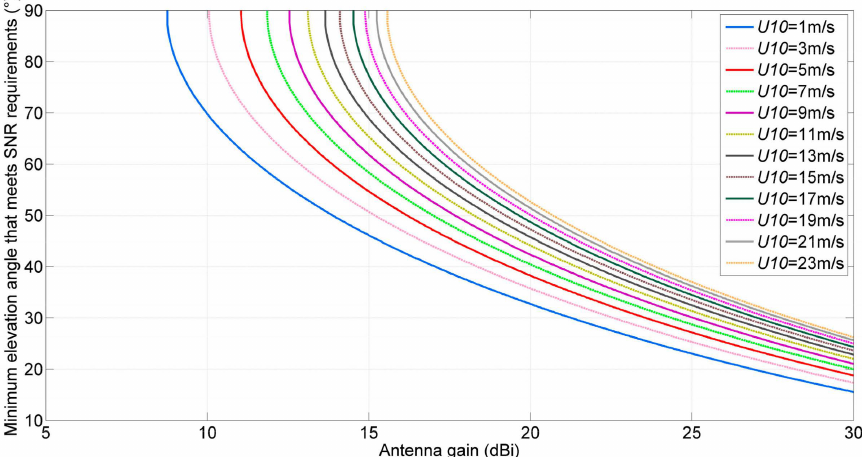
Figure 5. The relationship between the minimum elevation angle and the gain. The U 10 is the wind speed at 10 m height above the sea